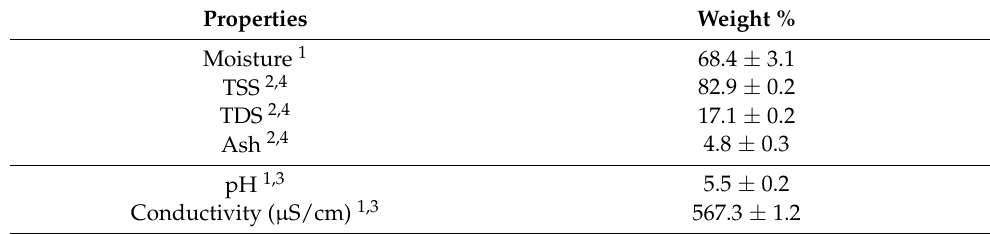
Table 1. Physico-chemical properties of wet pomace.